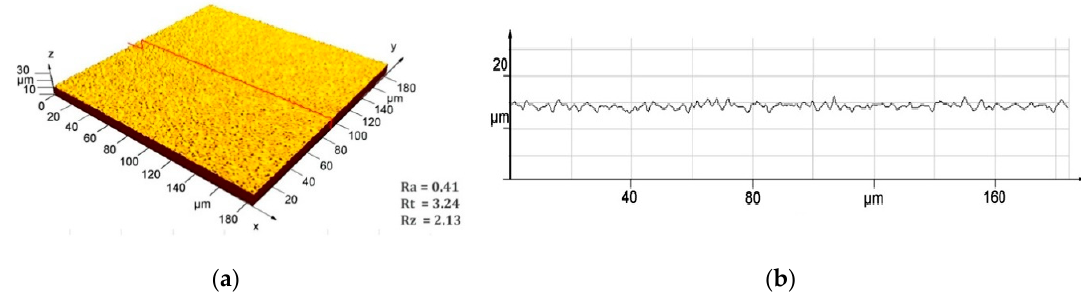
Figure 9. Profilograms of the hole surface machined by a reamer without coating: ( a ) 3D-profilogram of the hole surface; ( b ) 2D-profilogram of the hole surface.